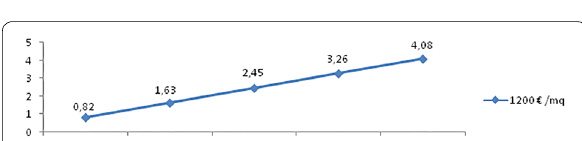
Fig. 6 Evaluation of the premium coefficient on the basis of the market value of new buildings and the depreciation coefficient of existing buildings for the case study of Villasor (on the x-axis the depreciation factor of the existing building, on the y-axis the premium coefficient)